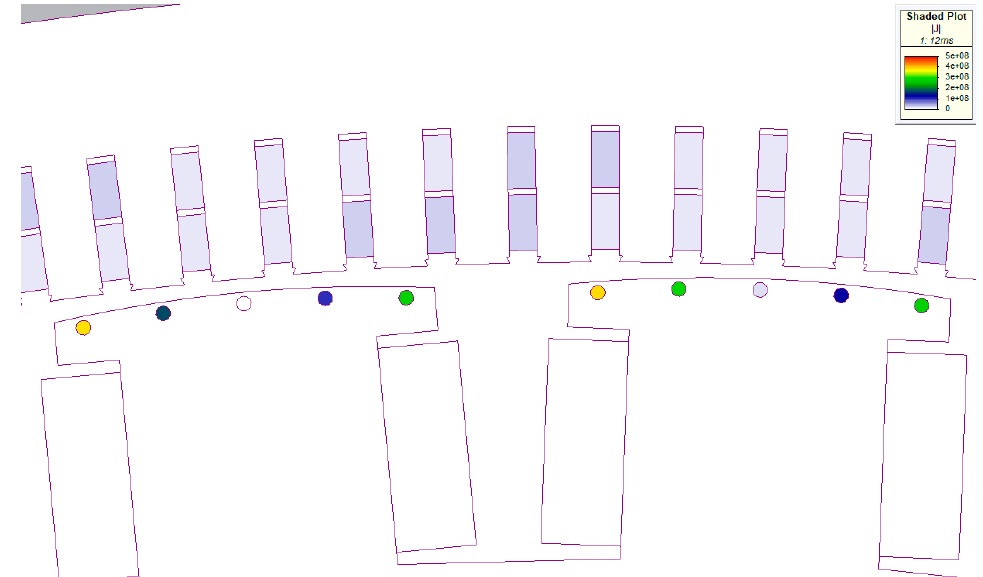
Figure 12. Presentation of current density in windings at half a period after short-circuit. The currents in the damping bars affect the saturation of the core above the